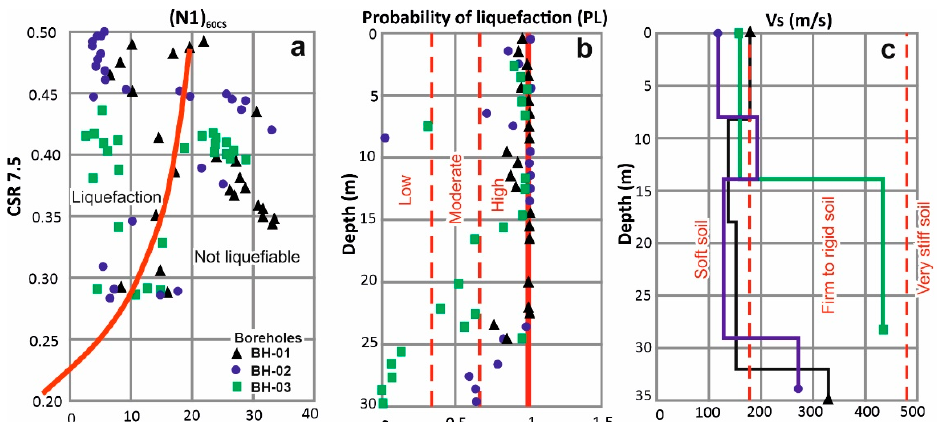
Figure 5. ( a ) Relationship between the Cyclic Stress Ratio (CSR) causing liquefaction and the value (N1) 60cs for silty sands. ( b ) Values obtained of liquefaction probability PL for sands from geoengineering drilling for the city of Jama. ( c ) Behaviour of S-velocity (Vs) to a depth of 35 m.